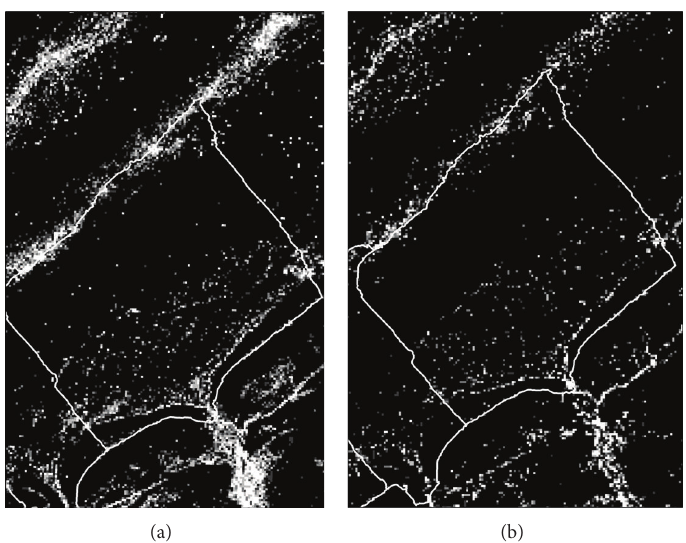
Figure 7: Pit fill metric on 10 × 10 meter blocks from CZO LiDAR (a) and PAMAP LiDAR (b). White areas correspond to high roughness